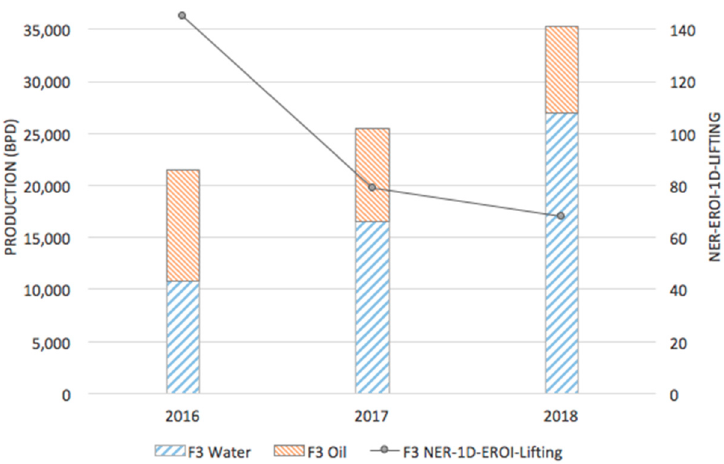
Figure 3. Field 3 Production vs. NER-1d-EROI Lifting.